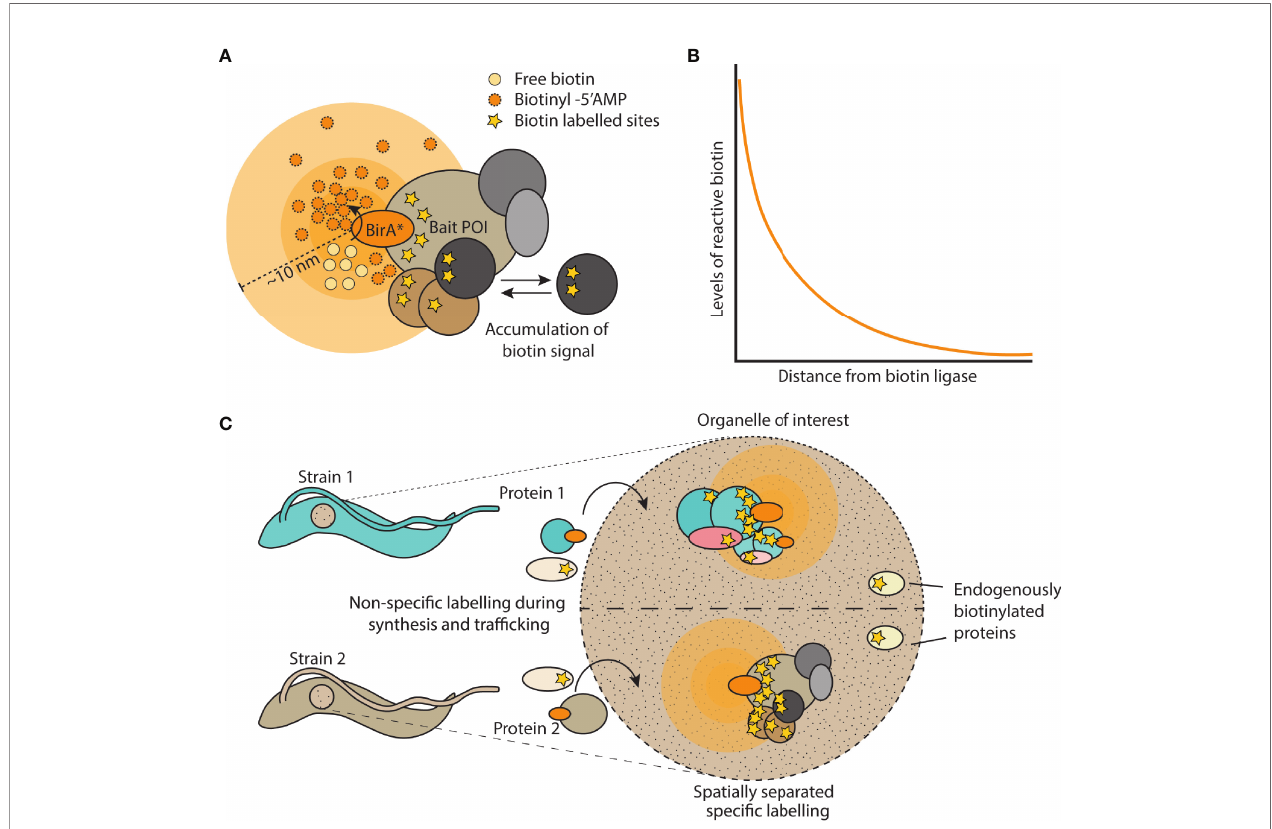
FIGURE 2 | Overview of proximity biotinylation by BirA*. (A) Cartoon depicting a bait protein of interest (POI) fused to BirA*. Free biotin is converted into a reactive biotinyl-5 ’ AMP which reacts with lysine residues in proteins within a 10 nm labelling radius. Signal accumulates over time due to dynamic changes in the protein complex. (B) Depiction of the exponential decay of reactive biotin levels as distance increases from the biotin ligase. (C) Example of using spatial or organellar control strains, in which a different protein is tagged with the biotin ligase and compared against the strain expressing the control protein. This allows for the computational removal of endogenously biotinylated proteins as well as labelled proteins that are not speci fi c to complexes of